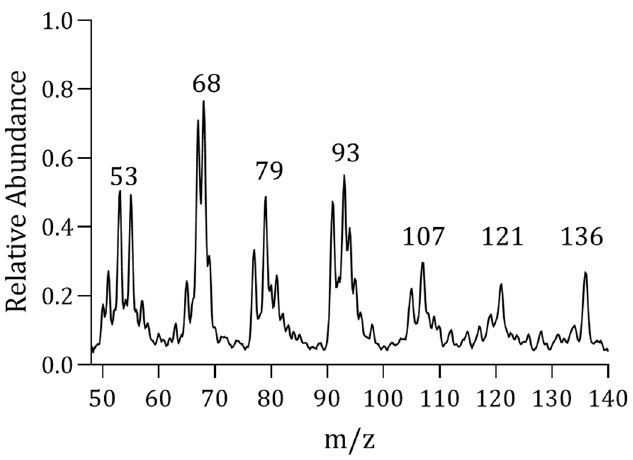
Figure 1. PY-MIMS spectrum of EU leaves.